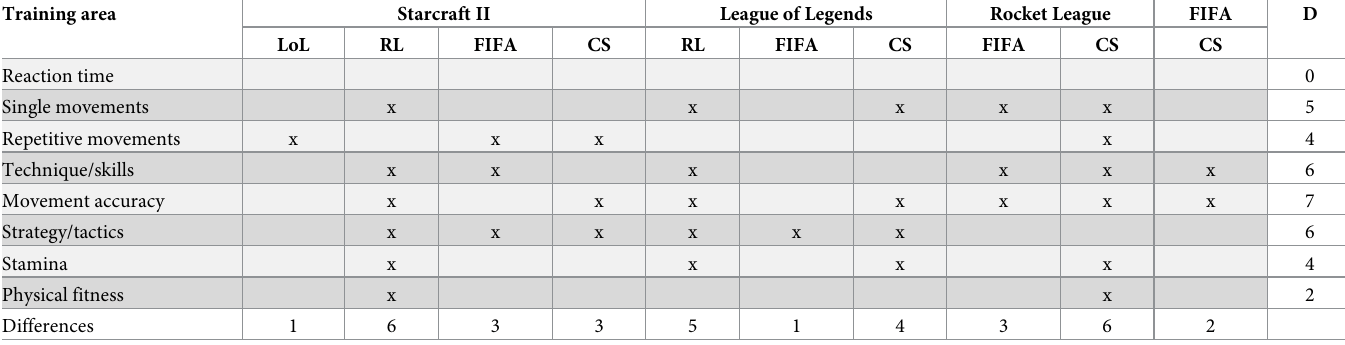
Table 18. Significant differences between the esports in the frequency of training in specific training areas (LoL = League of Legends; RL = Rocket League; CS = Counter Strike; D = Differences).